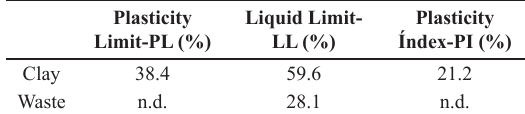
Figure 2. XRD of clay and dimension stone Table 2. Atterberg limits of clay and dimension stone waste.